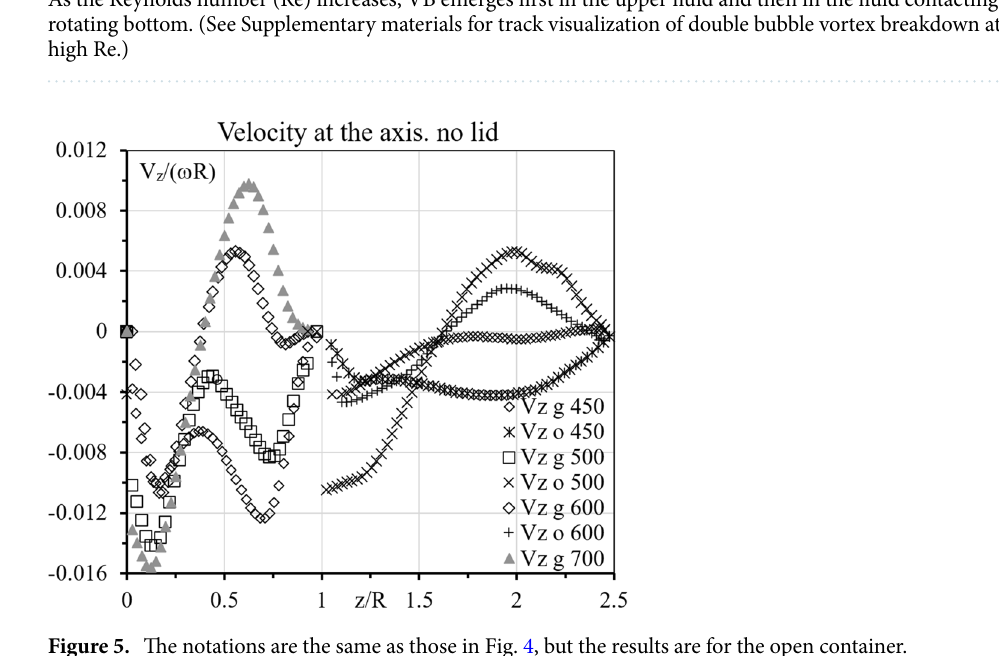
Figure 5. The notations are the same as those in Fig. 4, but the results are for the open